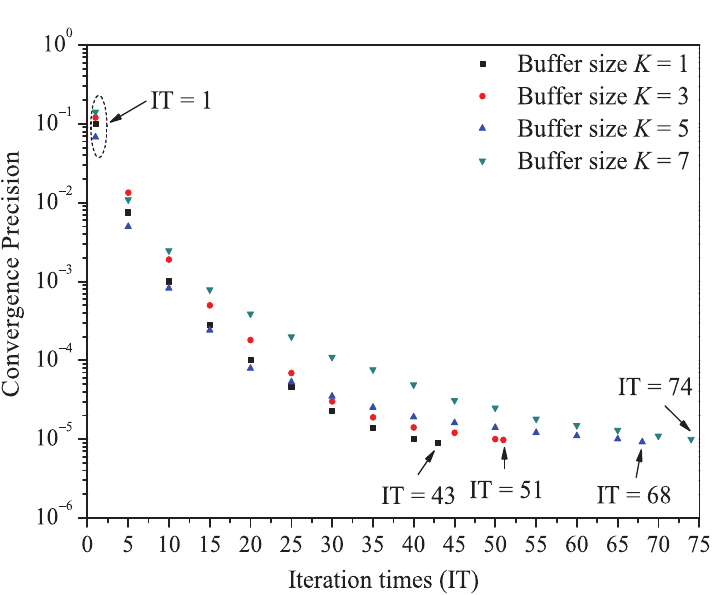
Figure A1. The relationship between iteration times and convergence precision under the impact of transit buffer size K